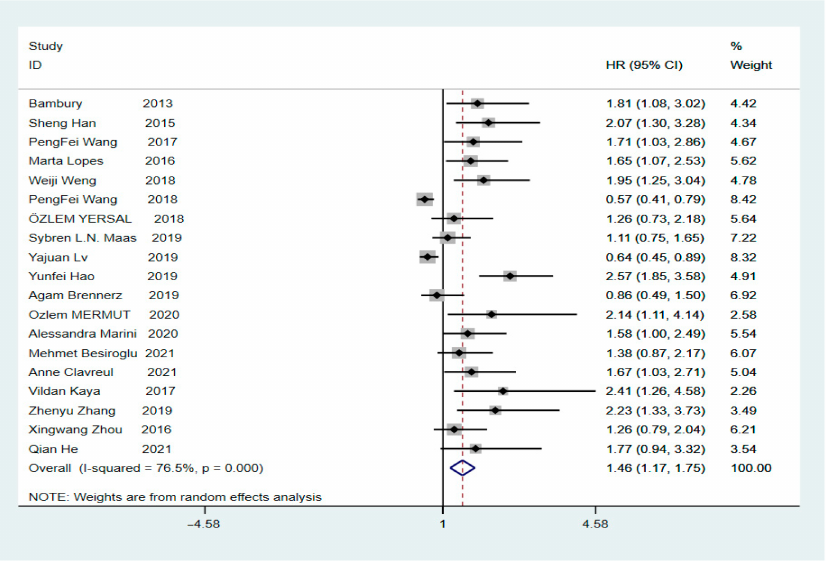
Figure 2. Forest plot illustrating the relationship between the NLR and OS in glioblastoma patients [4,9,19,20,22–36].